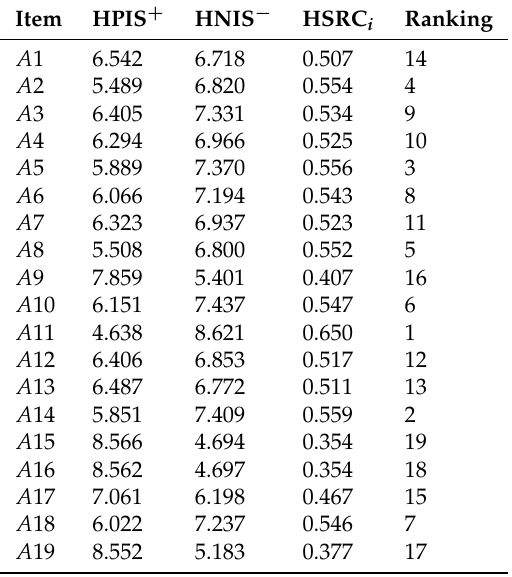
Table 6. Relative closeness ( HSRC i ) .